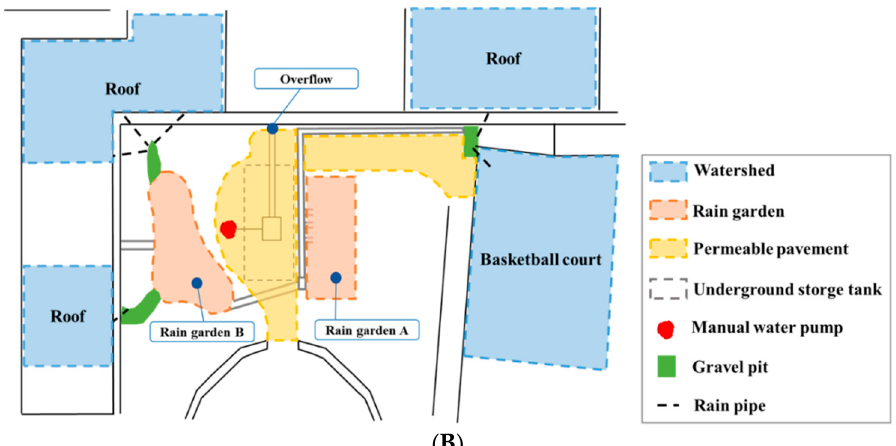
Figure 3. The studied raingarden site. ( A ) Site photo and ( B ) sketch of the site area. The monitoring periods for the two sites were different. The permeable pavement